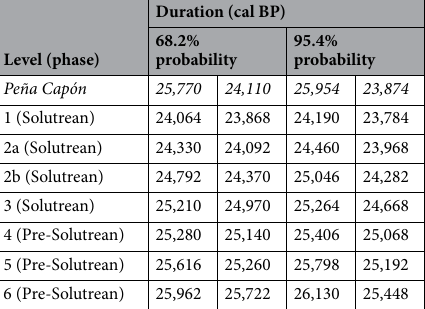
Table 1. Calendar age estimates for each archaeological level at Peña Capón, based on the Bayesian Model 2 (Fig. 6) as calculated by the ‘date’ command in OxCal 4.4 online software (https:// c14. arch. ox. ac. uk/ oxcal. html). Associated PDFs are shown in Fig. S22.